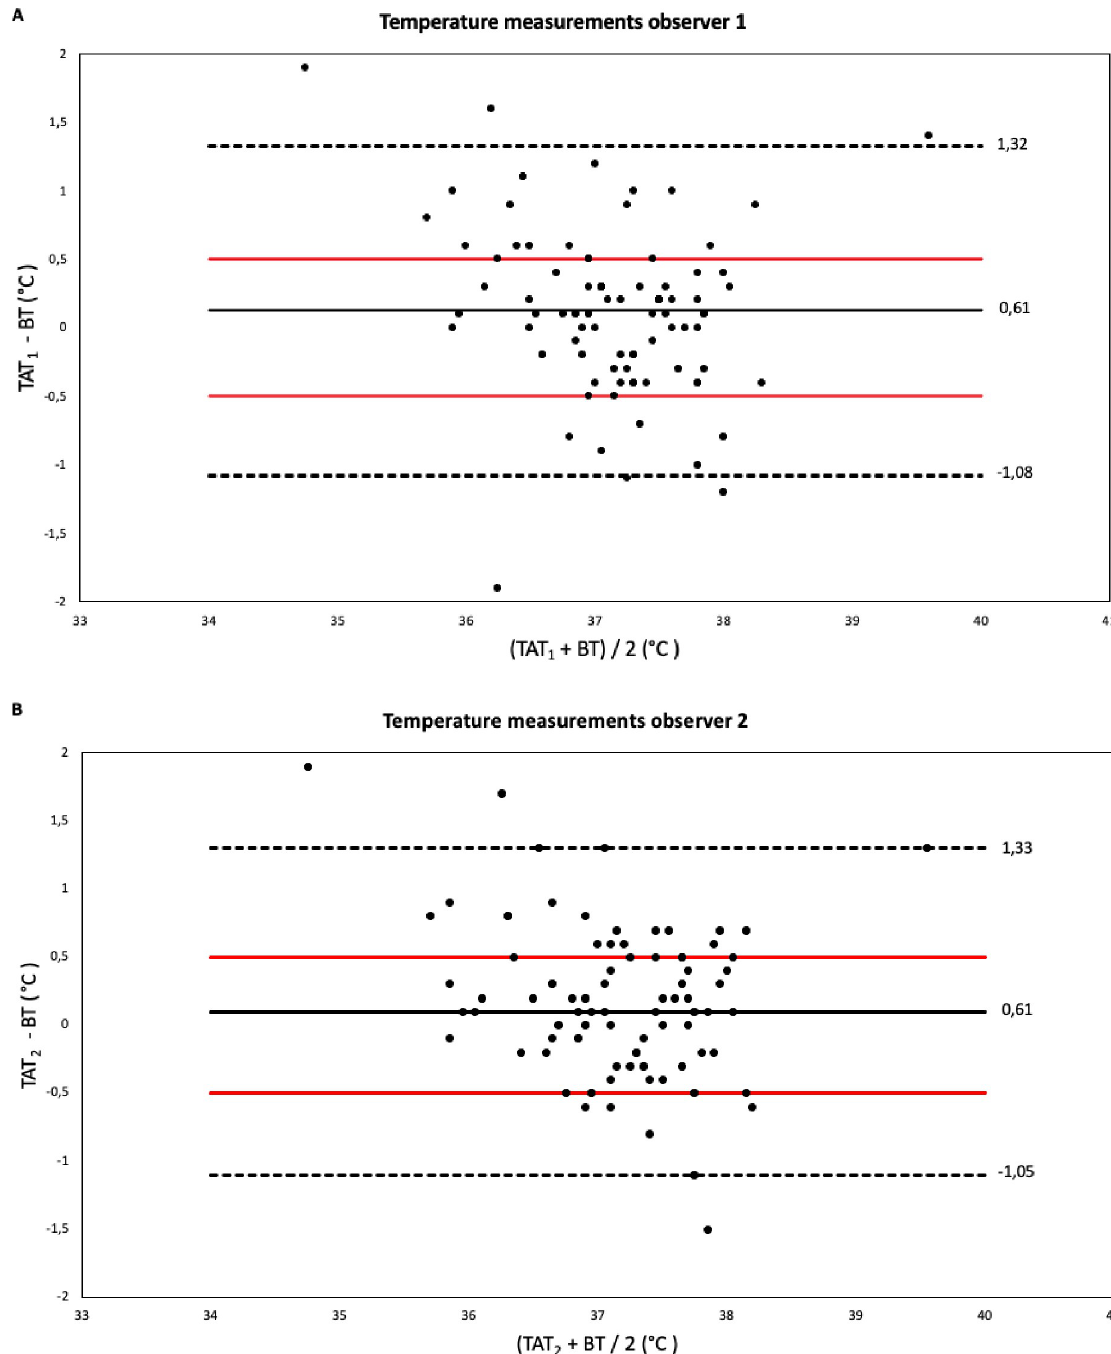
Fig 3. Bland Altman plots. A. Bland-Altman plot for body temperature. Comparison of the difference between paired temporal artery (TAT) and bladder temperature (BT) measurements of observer 1 (TAT 1 ) is illustrated. B. Bland-Altman plot for body temperature. Comparison of the difference between paired temporal artery (TAT) and bladder temperature (BT) measurements of observer 2 (TAT 2 ) is illustrated. In each plot, the continuous horizontal line represents the mean difference of the two measurements, and the upper and lower dashed lines represent the 95% limits of agreement. The two red lines represent a tolerance of